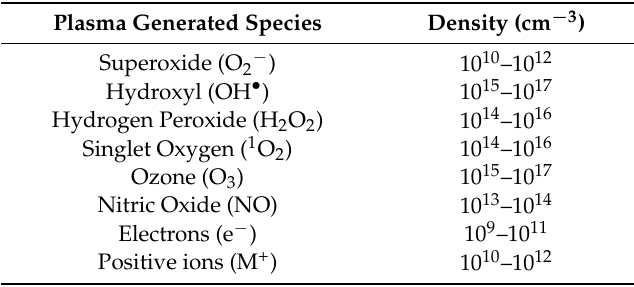
Table 1. Typical relative concentrations of various charged and neutral species generated by non-thermal DBD plasma in gas phase [17–20].